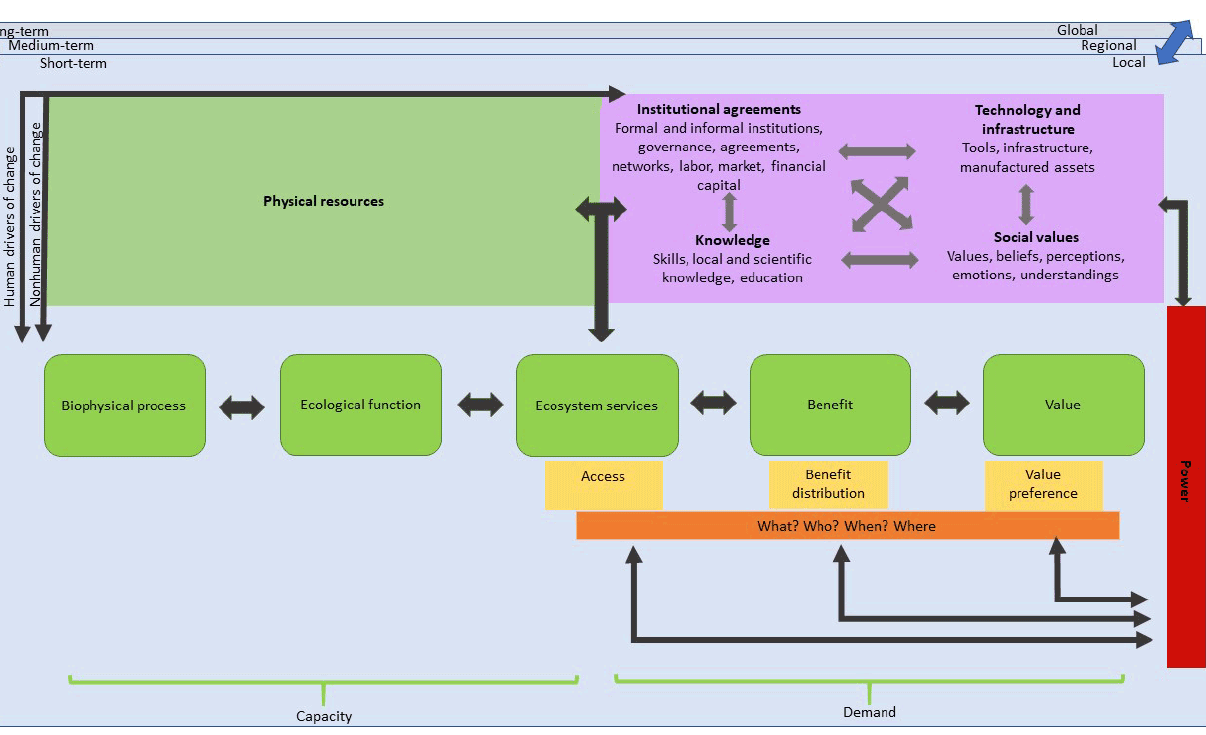
Fig. 3 . Conceptual framework that integrates the gaps identified during the review. The framework outlines coproduction and power relations as the core factors of assessments of coastal ecosystem services (ES). Relations of cascade-model components are bidirectional, not unidirectional. Cascade-model components are affected by human drivers of change (drivers that result from human decisions and interactions, such as institutions and governance, technology, market dynamics, etc.) and nonhuman drivers of change (drivers originated by natural dynamics, outside human control, such as natural climate phenomena). Note the mutual influence between human drivers of change, on the one hand, and institutions, governance, and other coproduction assets, on the other. ES services are not a free gift of nature, but are instead coproduced by human inputs. Although not all ES are coproduced equally, given that human contributions to ES might vary along the stages of ES production (Reyers et al. 2013, Guerry et al. 2015, Fischer and Eastwood 2016, Palomo et al. 2016, Outeiro et al. 2017). Power relations underpin access to ES, distribution of benefits, and definition and preference of values. All above-mentioned processes take place at different temporal and spatial scales and through interactions and feedback processes that operate at many scales. This complexity leads to high levels of